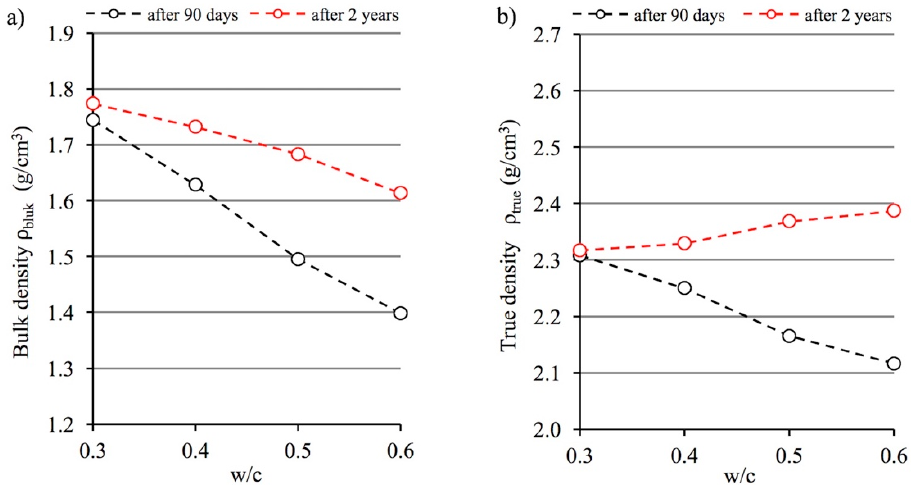
Figure 3. Relationship between bulk ( a ) and true ( b ) density versus the w/c ratio of cement pastes after 90 days and 2 years of curing.